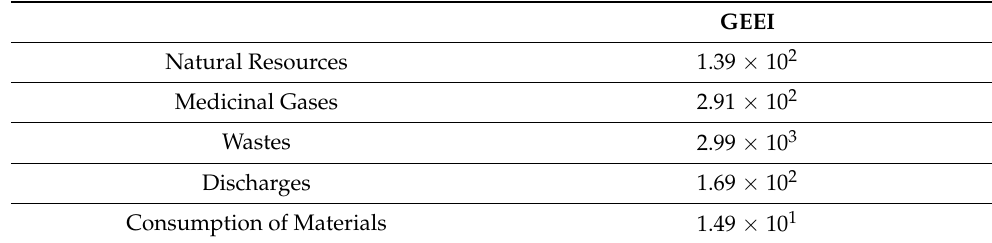
Table 6. Single-Value Environmental Efficiency Index (Hospital Activity) associated with the hospital activities and services provided in